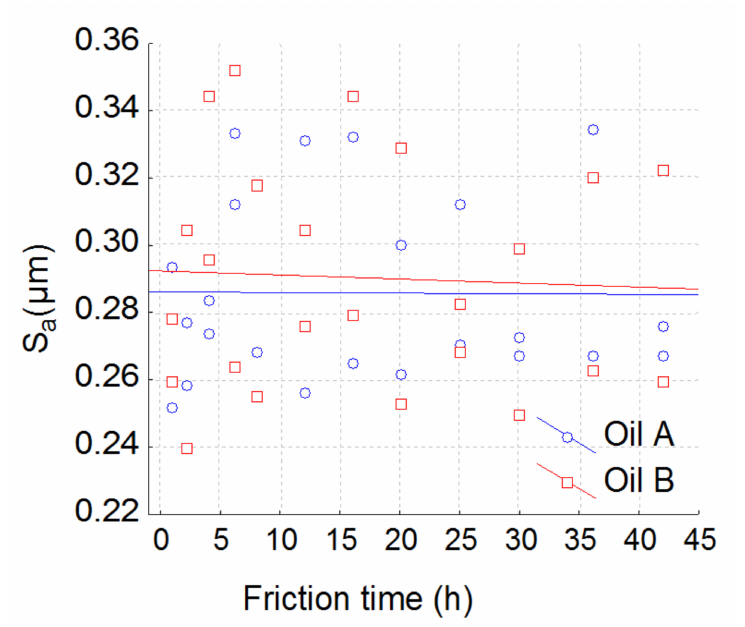
Figure 9. Plot of the most used parameters S a . This parameter is computed with a high pass filter with a cut o ff of 120 µ m.